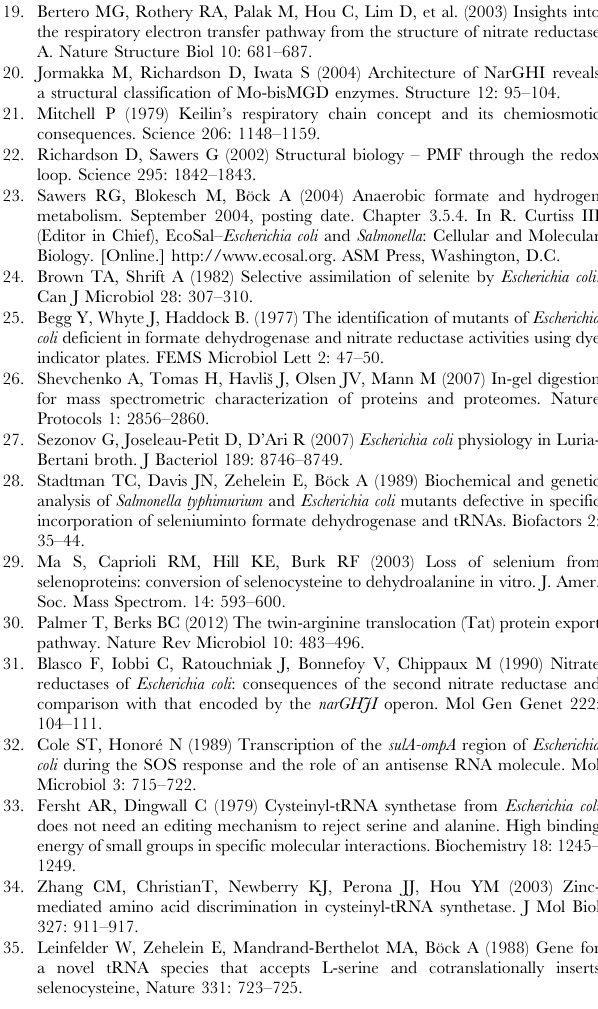
Figure S1 (A) Nano-ESI-LTQ-Orbitrap-MS data. The pre- cursor mass of the selenopeptide from FdoH with m/z 664.2949 matches the expected mass with a deviation of 0.26 ppm. The inset shows the characteristic isotope pattern of a selenopeptide. Signals corresponding to the selenopeptide are labeled with asterisks. (B, C) Nano-ESI-LTQ-Orbitrap-MS/MS data of the precursor ions LIDVTTcIGu 42 K (B, m/z 664.2949) and LIDVTT- cIGc 42 K (C, m/z 566.3073). Precursor ions were selected, fragmented, and analyzed in the linear ion trap (LTQ). MS/MS data unambiguously identify selenocysteine at position 42 of